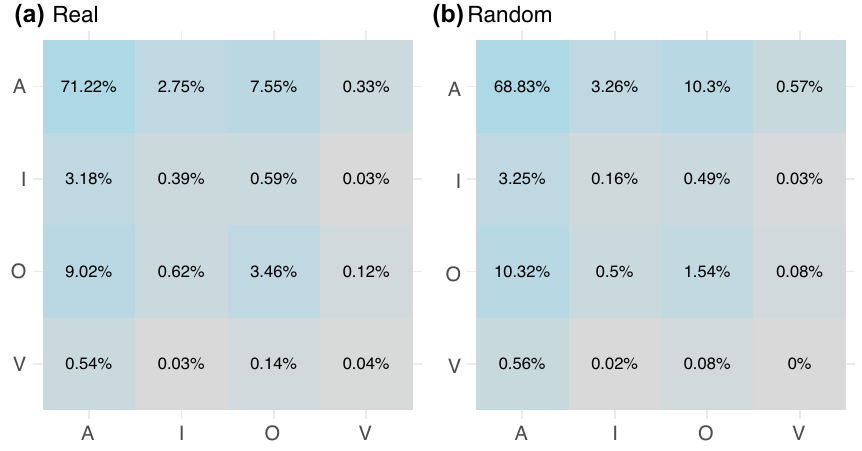
Figure 8. Transition probabilities between different comments types represented by a 4 × 4 transition matrix in the real (panel a ) and in the random case (panel b ). Brighter entries of the matrix indicate higher transition